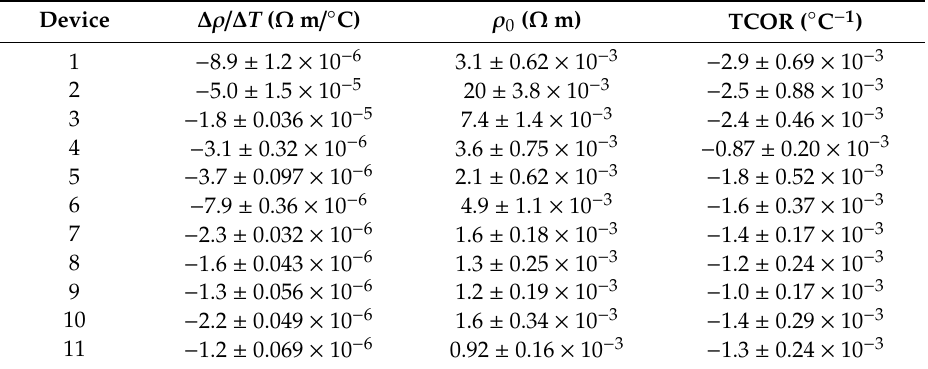
Figure 8. ( a ) Temperature dependent I SD – V SD curves of a single G-NS (device 3) from 10 – 80 °C, where the inset is an expanded view of the upper range of I SD – V SD , and ( b ) the resistivity vs. temperature profile for the same single G-NS, which displays a negative linear slope. Table 2. The slope of the resistivity vs. temperature profile ( ∆ ρ / ∆ T ), the resistivity at the reference temperature ( ρ 0 ), and the calculated TCOR for each